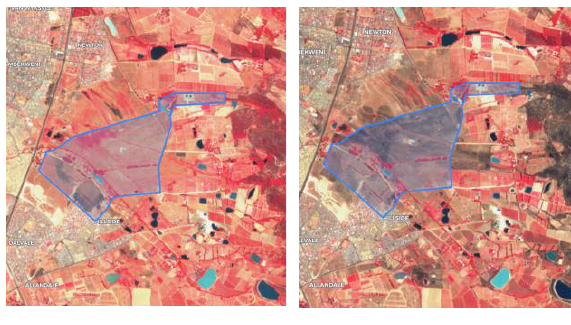
Figure 2: The Dal Josafat Cultural Landscape in 2017, post fire, burn scars are shown as black areas (Modified Copernicus Sentinel data, 2017/Sentinel